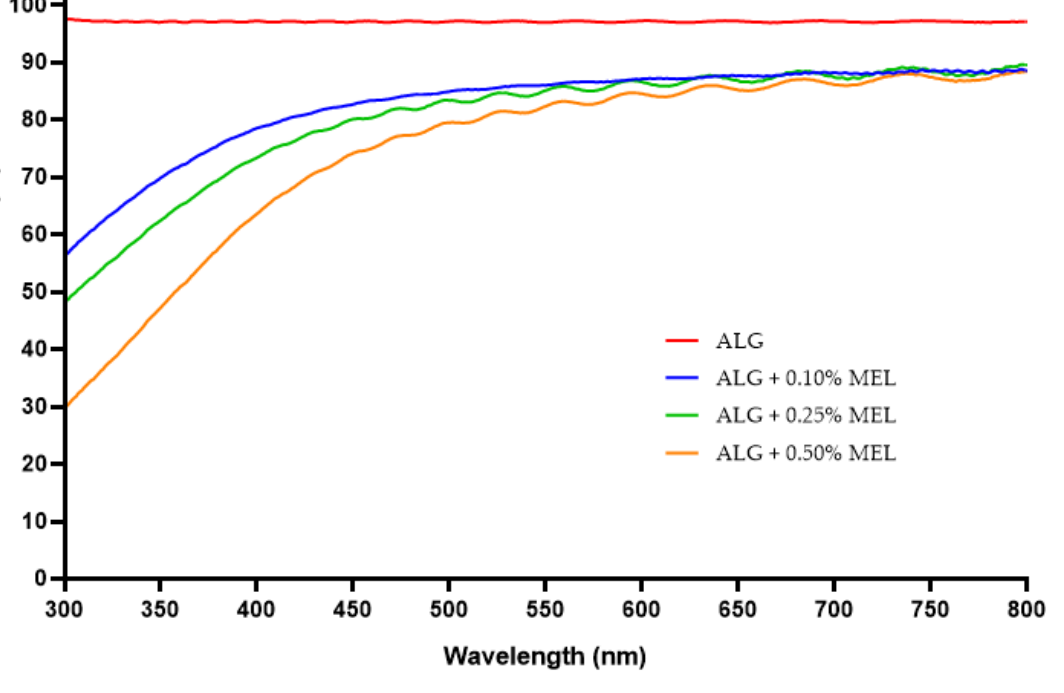
Figure 4. UV-Vis spectra of unmodified and melanin-modified alginate films.